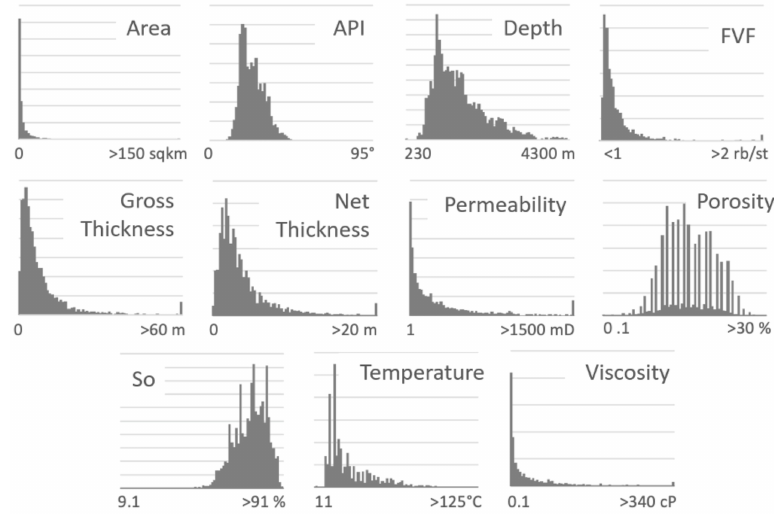
Figure 6. Histograms show attribute data distributions for Basin X